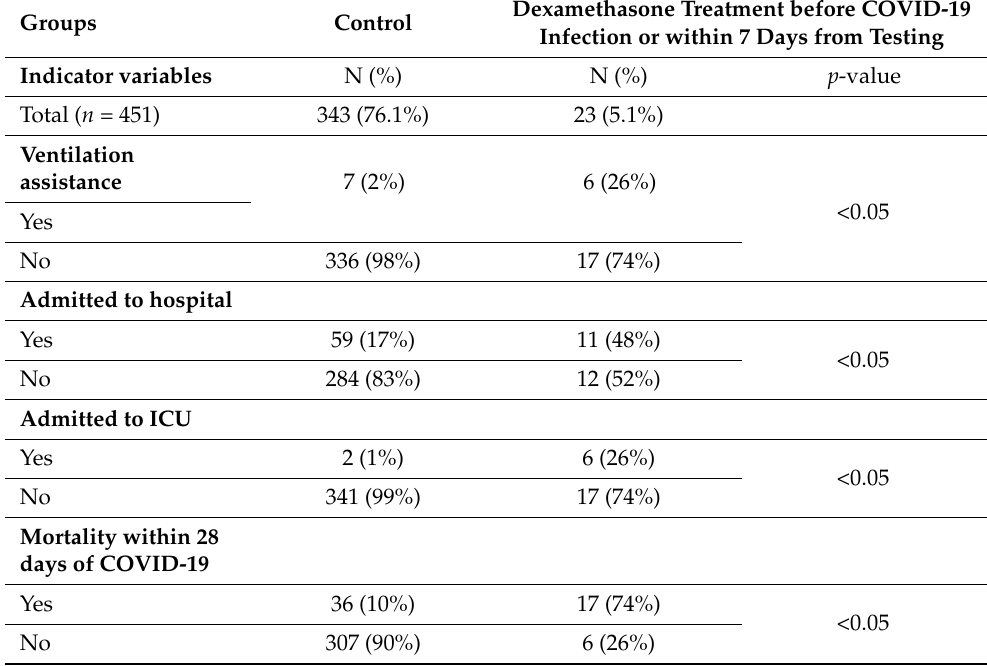
Table 3. Effect of dexamethasone treatment before COVID-19 infection on disease indicators. Groups